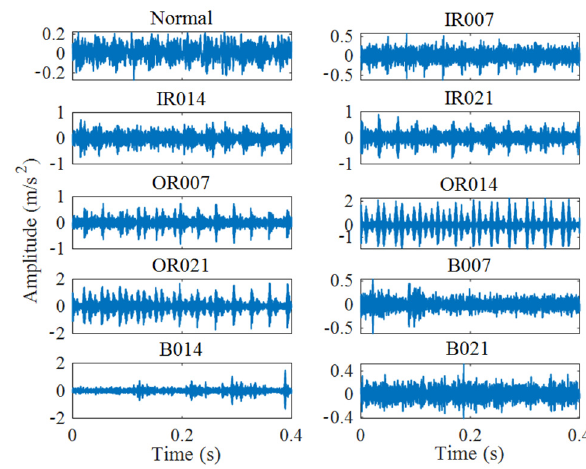
Figure 3. Time − domain diagrams of bearing in ten states (1).